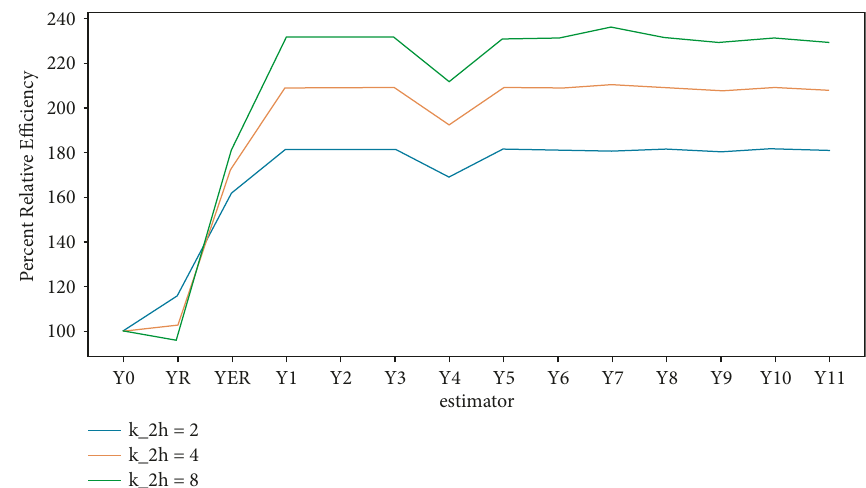
Figure 1: Plot of PREs at 20% nonresponse and 0.2 sensitivity level for population